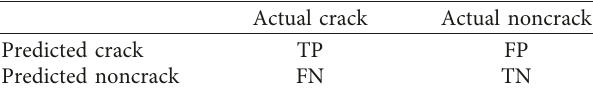
Figure 10: Parameter visualization results. Table 1: Confusion matrix for crack